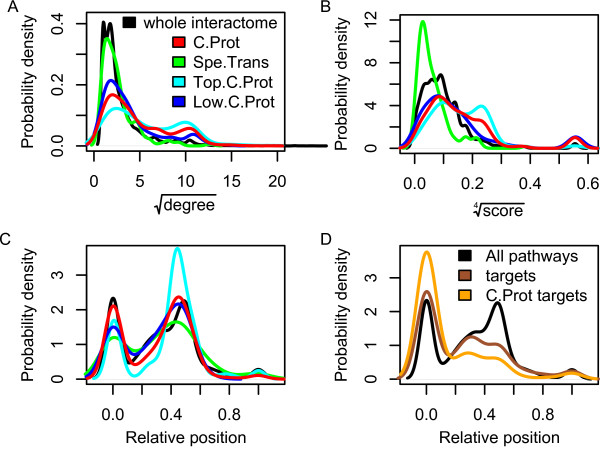
Network and pathways statistics. (A) Node degree (number of edges). Note the strong shift of C.Prot towards higher values. We also observe the absence of shift of the tissue specific genes (Spe.Trans) and the gradual shift from low abundant C.Prot entities to high abundant ones. (B) Eigenvector centrality values also display similar shifts, although in this case Spe.Trans even reverses the trend and differences between low and high abundant C.Prot are more modest. (C) Relative positions in pathways; 0 = beginning, 1 = end. No real bias for C.Prot but a strong preference for central position for its abundant proteins. Spe.Trans and low abundant C.Prot are more spread over all possible positions. (D) The same for drug targets. Note the strong shift towards initial positions for C.Prot drug targets, which significantly amplifies the already present preference of drug targets for such positions.